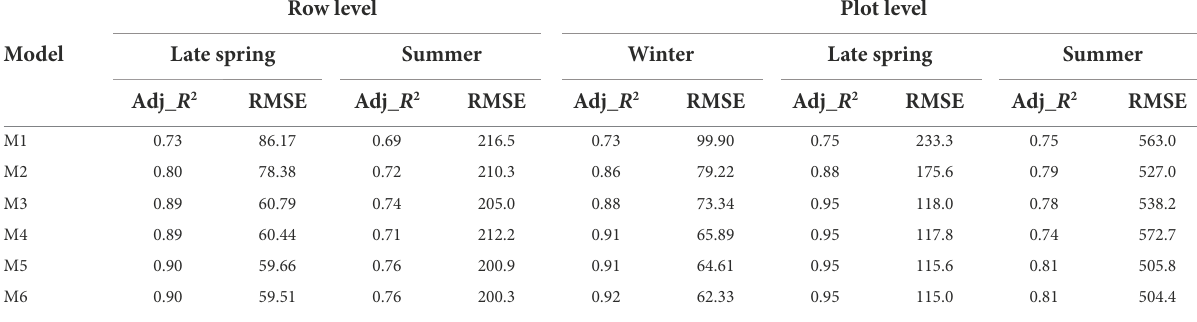
TABLE 3 Comparison of regression performance of models to predict biomass at row and plot levels in seasonal datasets.